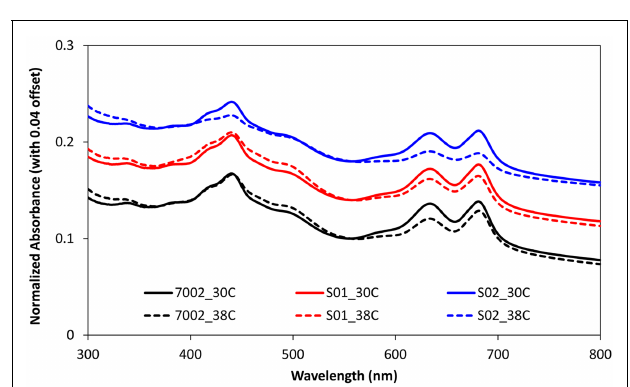
FIGURE 3 |Absorbance spectra of Synechococcus sp. PCC 7002 strains at day 16 for 30°C (solid lines) and 38°C (dashed lines) conditions . OD readings were normalized with respect to OD 556 to account for variations in cell density, and spectra for each strain were offset by 0.04 to aid in visualization.The phycobiliproteins, phycocyanin, and allophycocyanin, have a peak at 635nm, and chlorophyll- a pigments have a peak at 680nm with Soret bands at